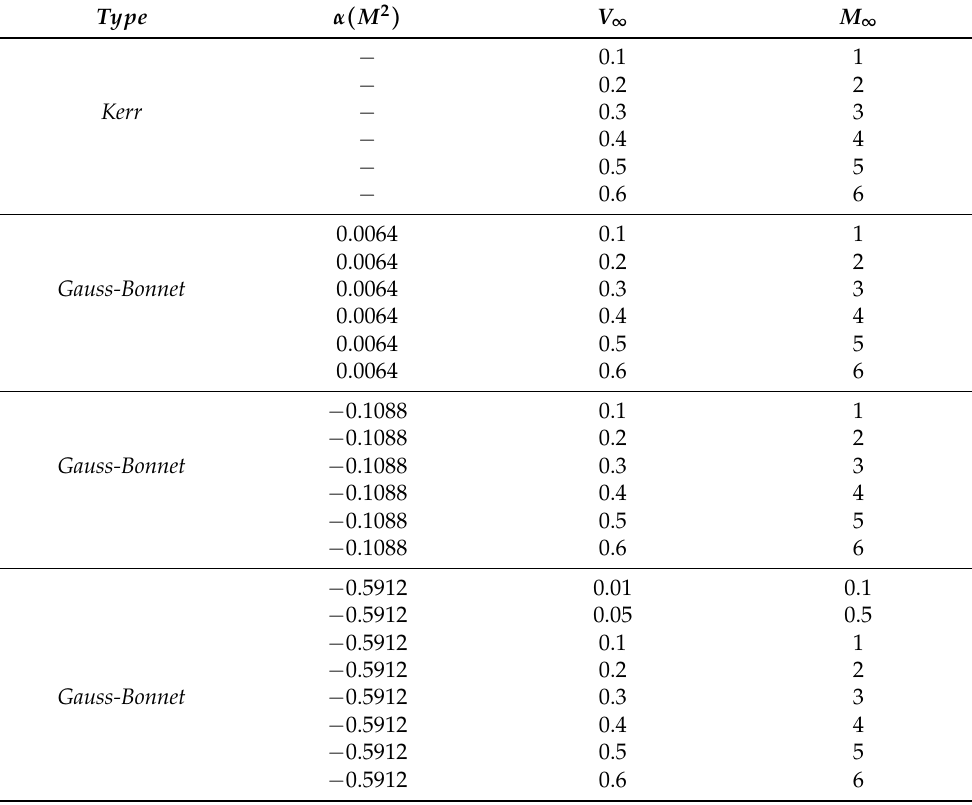
Table 1. Adopted initial model used in the numerical simulation for Kerr and Gauss–Bonnet black holes. type is the black hole types used in numerical simulations. α is the Gauss–Bonnet coupling constant, V ∞ is the asymptotic velocity of the matter falling towards the black hole at infinity, and M ∞ = V ∞ / C ∞ is the asymptotic Mach number at